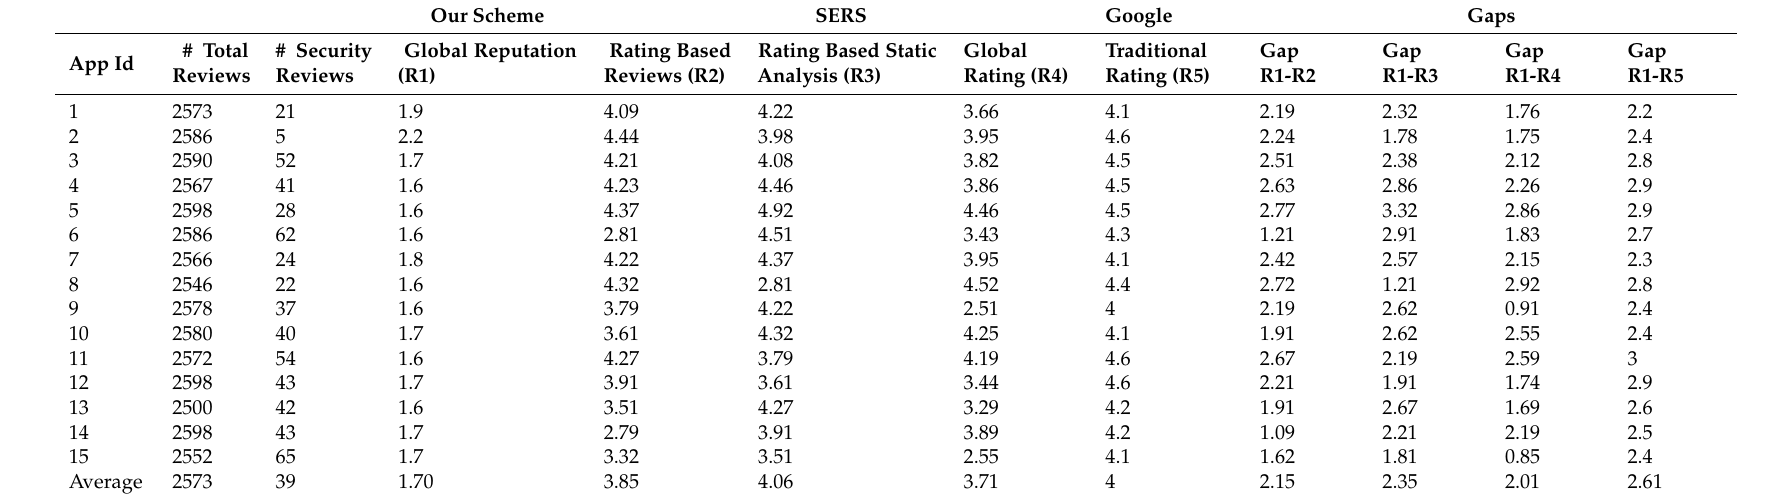
Table 8. Results about reputation and rating with